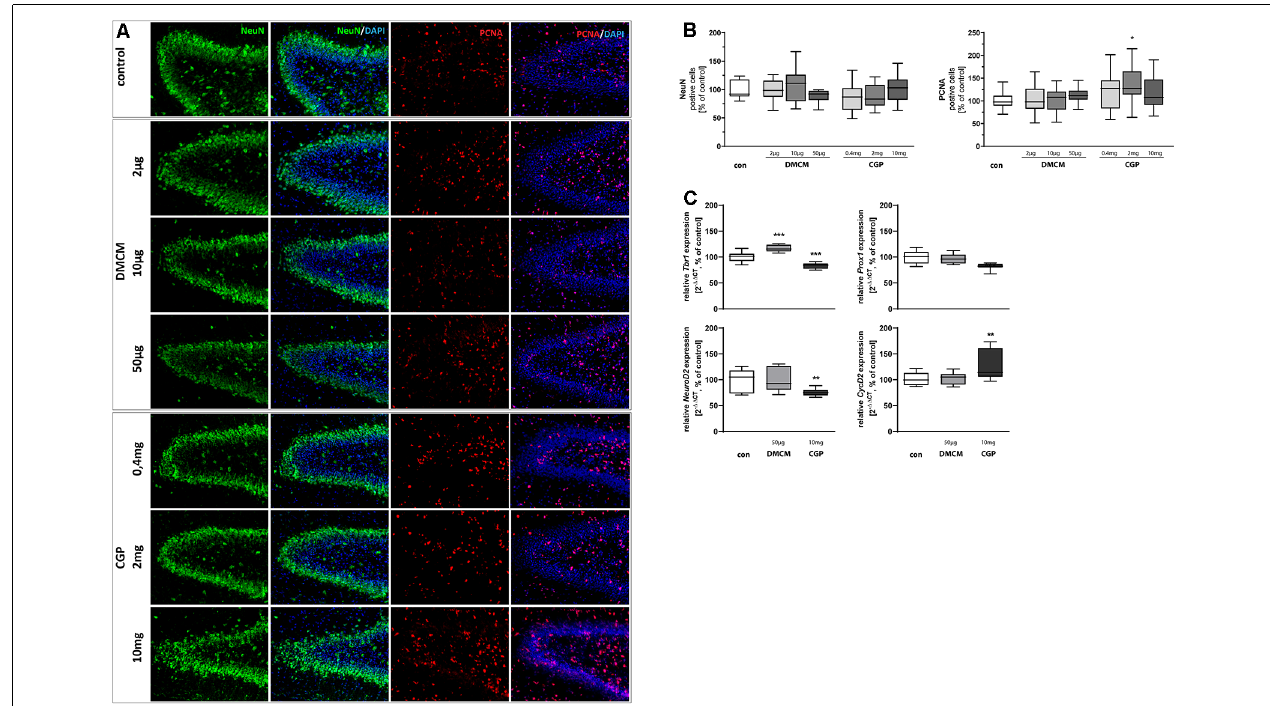
FIGURE 3 | Representative hippocampal paraffin sections (A) of control animals, DMCM hydrochloride (DMCM) in doses of either 2 µ g/kg, 10 µ g/kg or 50 µ g/kg, and CGP 35348 in doses of either 0.4 mg/kg, 2 mg/kg or 10 mg/kg treated rat pups at P11 co-labeled with DAPI, NeuN, and PCNA. Application of GABA receptor antagonists did not affect cell counts for postmitotic NeuN+ neurons at the DG. Application of CGP 2 mg/kg led to an increased number of proliferating PCNA+ cells. Quantification of (B) NeuN and PCNA positive cells in sum of the DG in comparison to control group (100% white bars). Data are expressed relative to the control group as mean ± SEM of n = 10 each group. The 100% values are for NeuN+ 143.0 cell counts and for PCNA+ 81.8 cell counts. * p < 0.05 vs. control (Brown-Forsythe test). Expressions of (C) Tbr1 and NeuroD2 are reduced and expression of CycD2 is increased in CGP treated animals. Expression of Tbr1 is increased in DMCM treated animals. GABA receptor antagonists do not affect the expression of Prox1 . The relative mRNA expressions of markers were measured by quantitative real-time PCR in rat brain homogenates with DMCM 50 µ g/kg (gray bars) or CGP 10 mg/kg (black bars) application relative to control (white bars). Bars represent the relative mRNA quantification based on internal standard HPRT . Data shown as mean ± SEM, n = 9–10. ** p < 0.01 and ∗∗∗ p < 0.001 vs. control (Brown-Forsythe test for CycD2 and NeuroD2 , one-way ANOVA for Tbr1